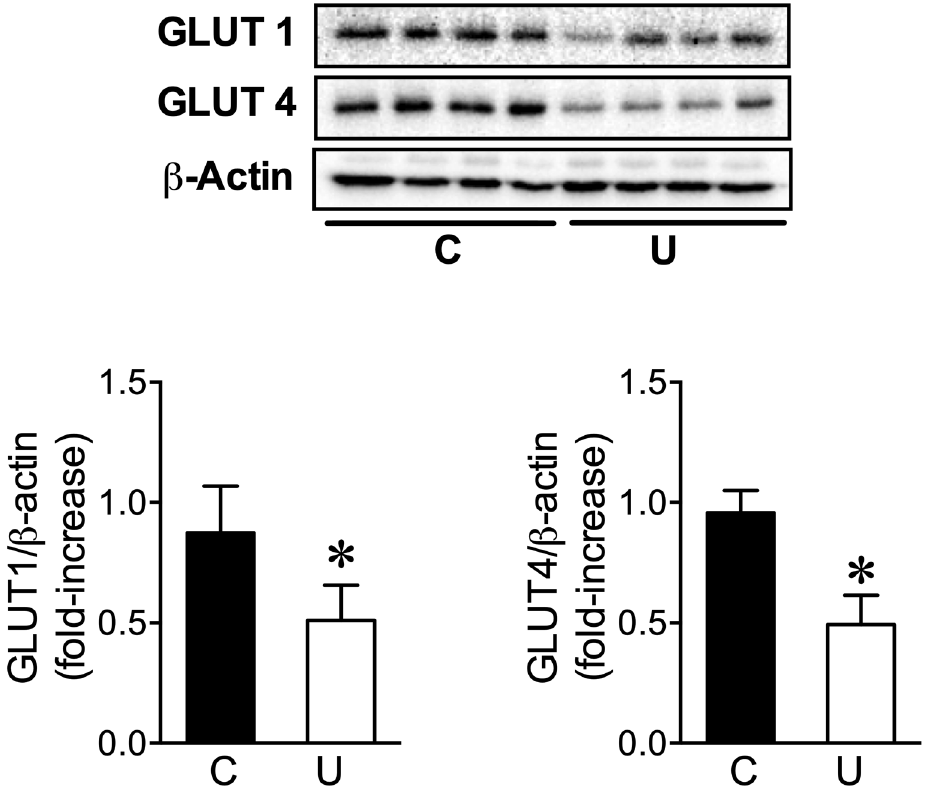
Figure 4. Effect of IUGR on glucose transporters content (GLUT-1 and GLUT-4) in the skeletal muscle from neonates. Top: Immunoblots for the indicated proteins in skeletal muscle homogenates from 3-h fasted neonates. Bottom: Bars represent densitometric quantification of GLUT-1 and GLUT-4 blots relative to β-actin protein levels from 6 to 8 individual animals per group. All values are mean ± SD. * p < 0.05 U versus C